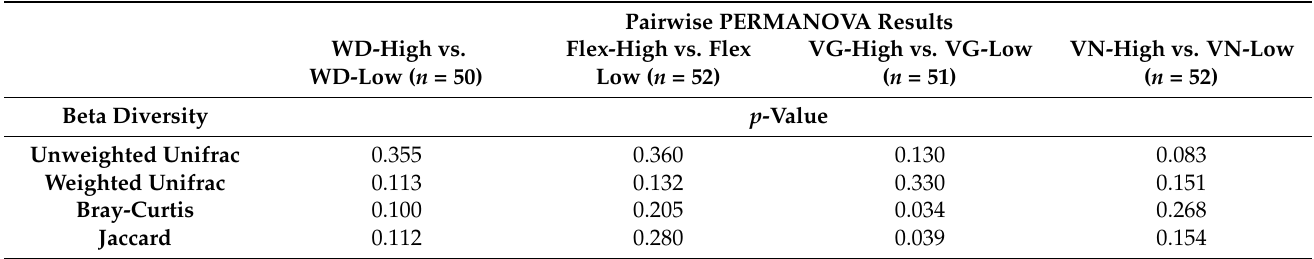
Table 3. Results of the pairwise PERMANOVA statistical analysis of beta diversity metrics between high and low fiber content groups of the same diet.